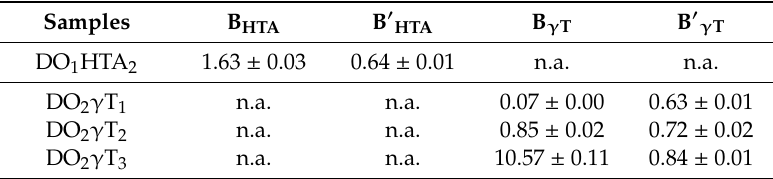
Table 7. Bioaccessibility of hydroxytyrosol acetate (HTA) and gamma -tocopherol ( γ T) in the digestates of the di ff erent samples in which these compounds are present, expressed in two di ff erent ways. B = (mmol PC D / mol (AF + GA) D ) and B (cid:48) = (mmol PC D / mmol PC O ). Values are the average of two determinations together with their standard